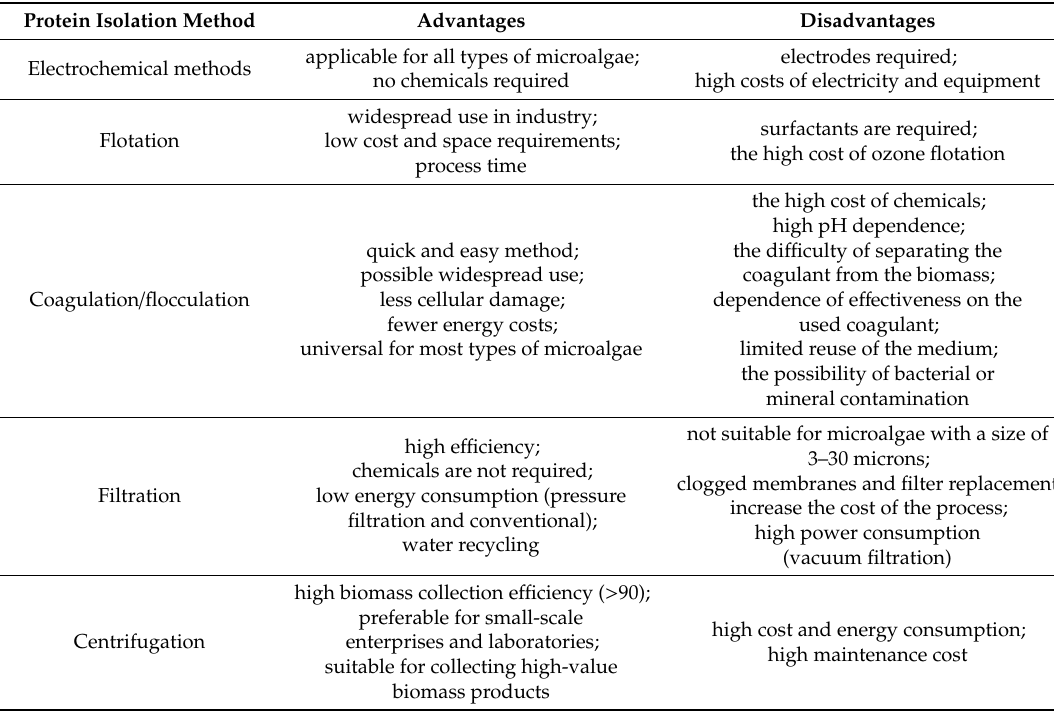
Table 7. Advantages and disadvantages of various methods for protein isolation from microalgae biomass (table built using combined data from previous studies [48–58]). Protein Isolation